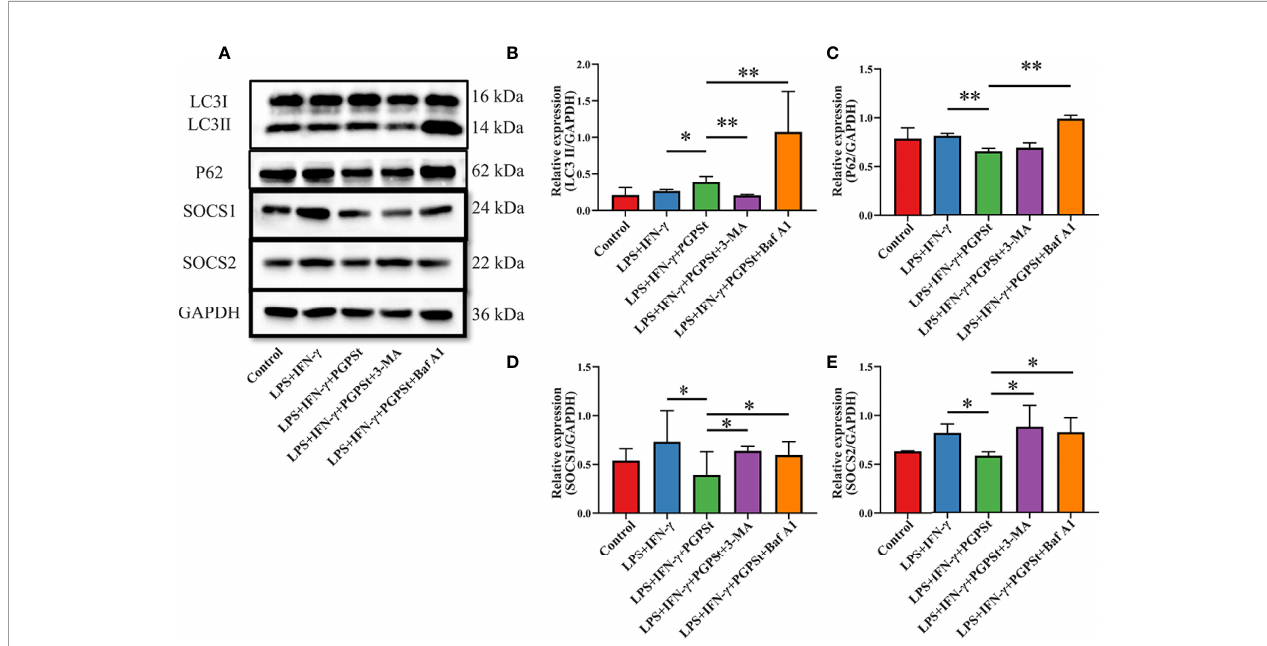
FIGURE 5 | Effect of PGPS t on SOCS1/2 expression through autophagy regulation. (A) Western blot analysis of LC3, P62, and SOCS1/2 in 3D4/21 cells in the presence or absence of 3-MA or ba fi lomycin A1; (B) Western blot analysis of LC3II/GAPDH expression; (C) Western blot analysis of P62/GAPDH expression; (D) Western blot analysis of SOCS1/GAPDH expression; (E) Western blot analysis of SOCS2/GAPDH expression. Means ± SD are indicated (n = 3). * indicates P < 0.05; ** indicates P <